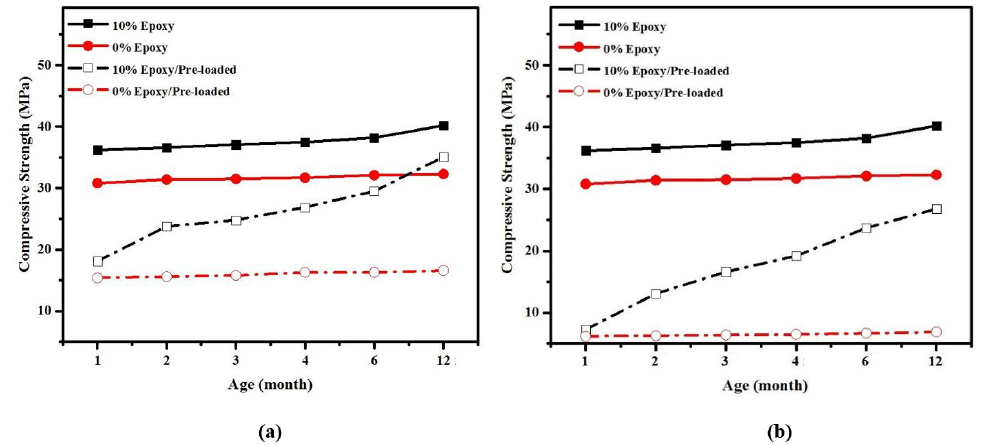
Figure 12. Self-healing efficiency of epoxy resin on CS development of pre-loaded specimens ( a ) 50% ( b ) 80%.